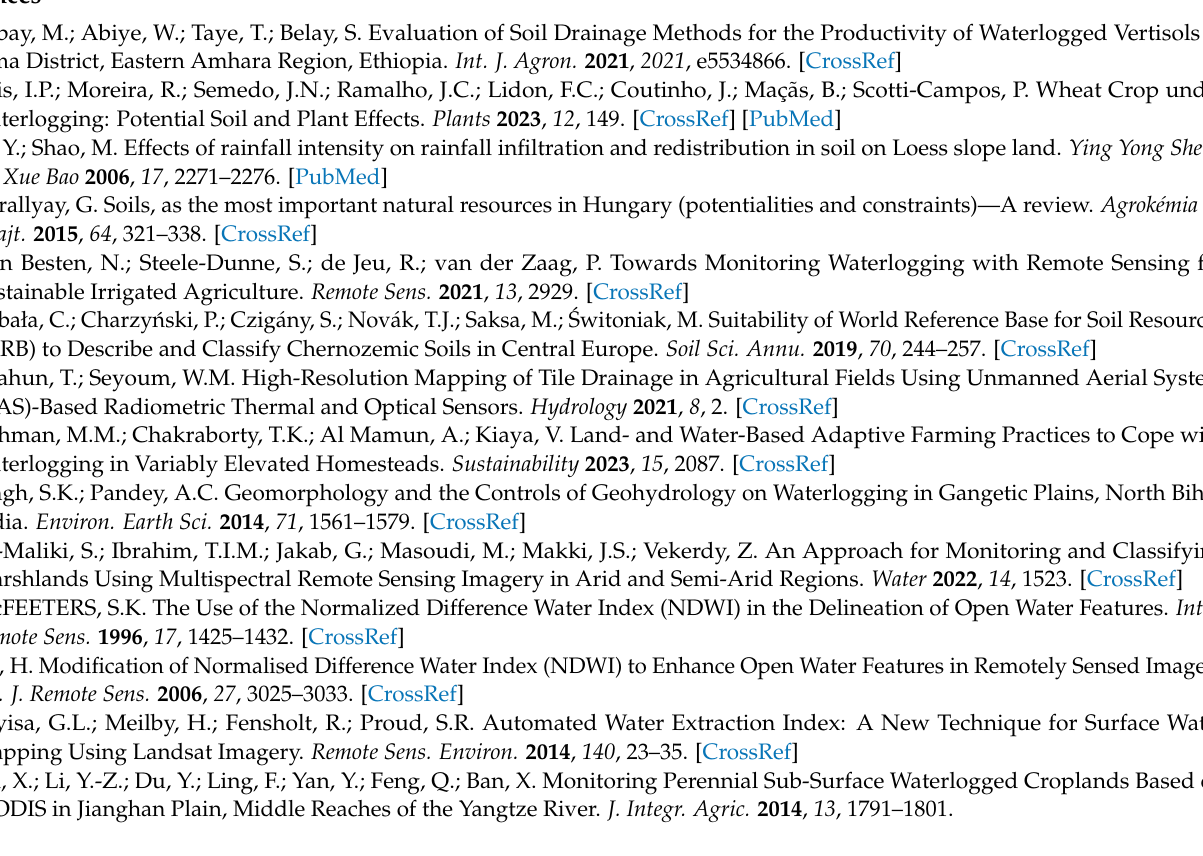
Figure A5. Distribution of ECa data based on the clustering results. Note a wider range of ECa in well-drained sites (orange color) and a narrow range of high ECa values in water-affected sites (blue color).